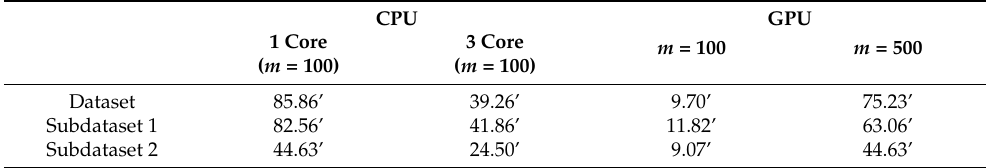
Table 6. Time comparison. m is the number of